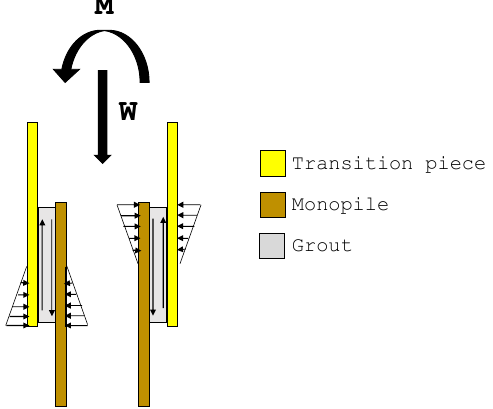
Figure 1. Pressure and force distribution on the grout connection.